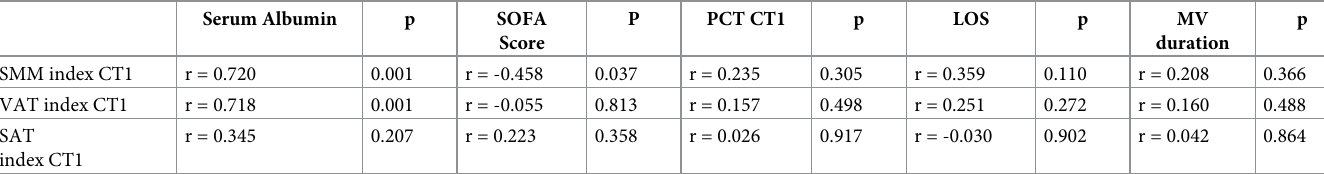
Table 2. Correlation between body composition at admission and clinical-biological parameters. Serum Albumin